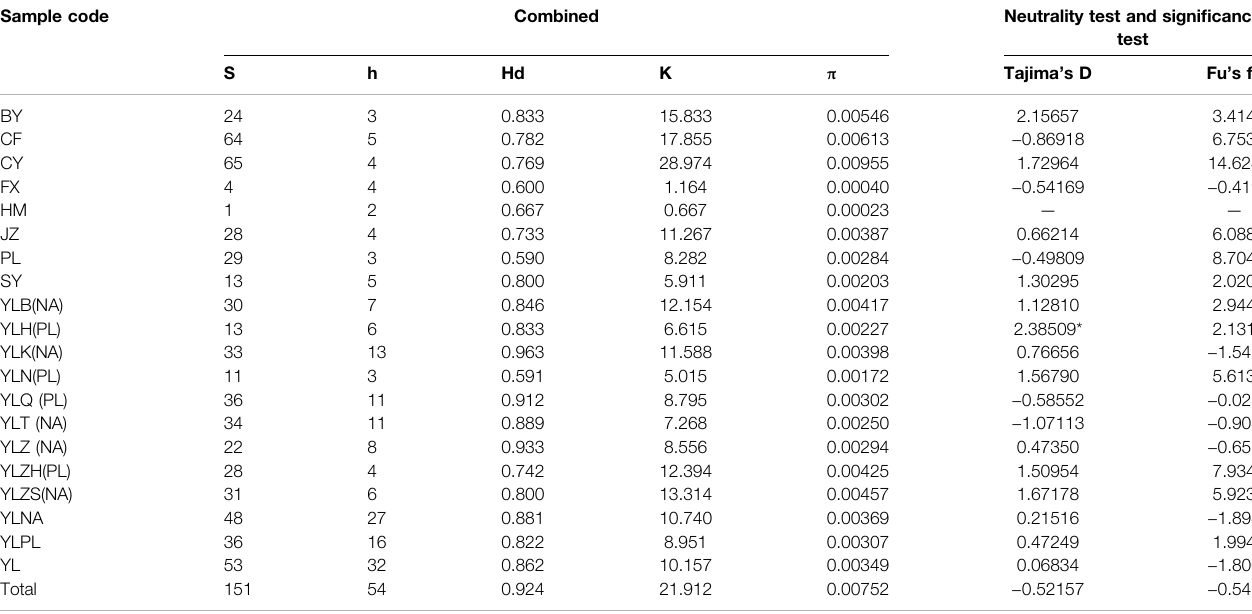
TABLE 3 | Genetic diversity parameters and neutrality tests among 17 populations of A. mali based on combined genes. Sample